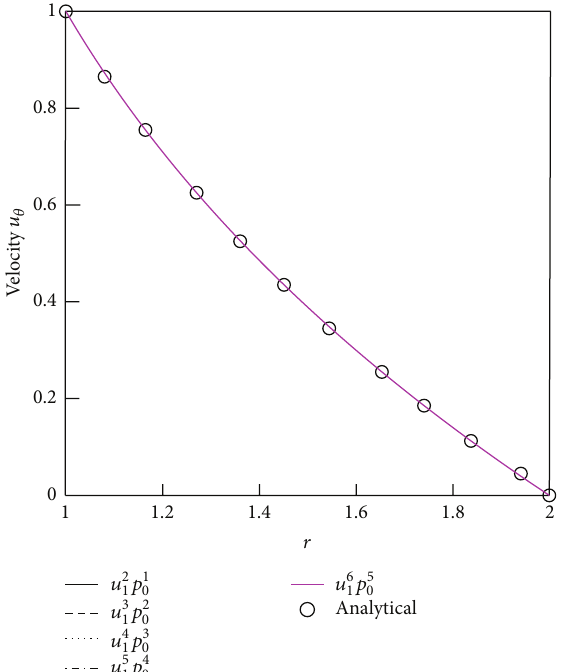
Figure 15: Distribution of tangential velocity 𝑢 𝜃 on radial coordi-